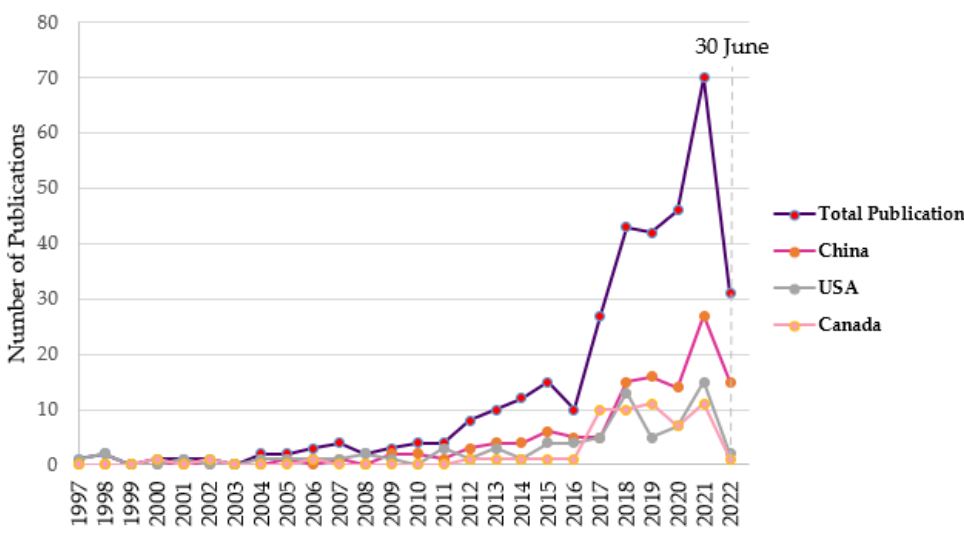
Figure 4. Temporal distribution and the total number of reviewed papers per year, and publication trends from three top publishing